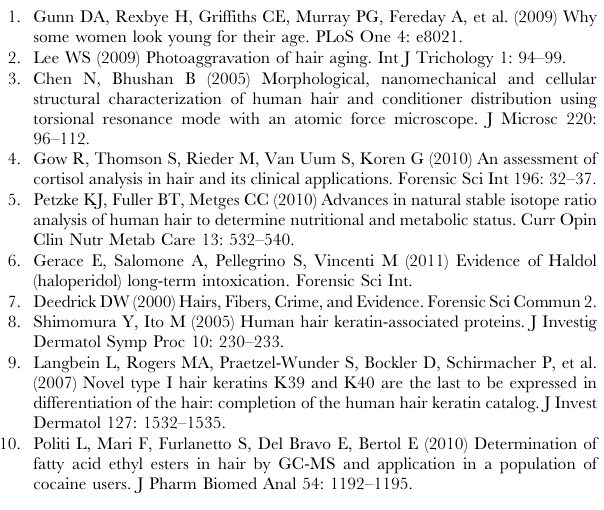
Figure S1 Light microscopic images of hair sections of 20-YO group. High resolution microscopic images of the hair